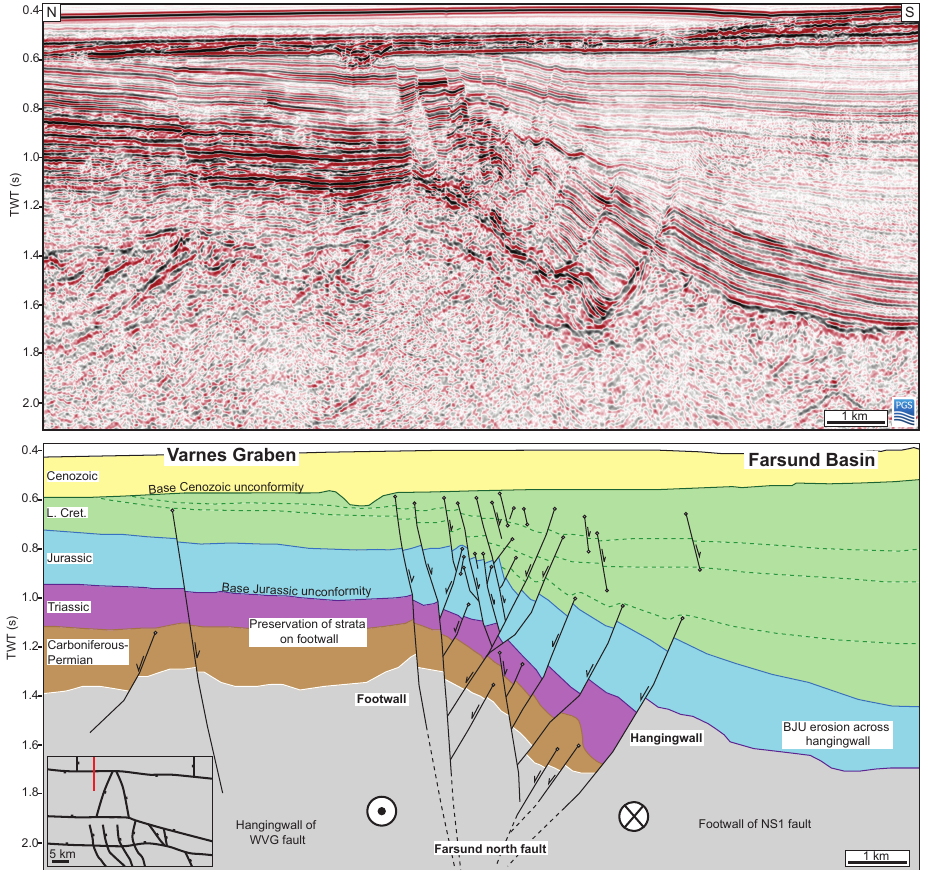
Figure 11. Interpreted and uninterpreted N–S-oriented 2-D seismic section across the Farsund north fault. Preservation of Carboniferous– Permian and Triassic strata across the footwall of the Farsund north fault with concomitant erosion across the hangingwall represents the same hangingwall–footwall juxtaposition demonstrated in Fig. 10. See Figs. 1c, 10 for